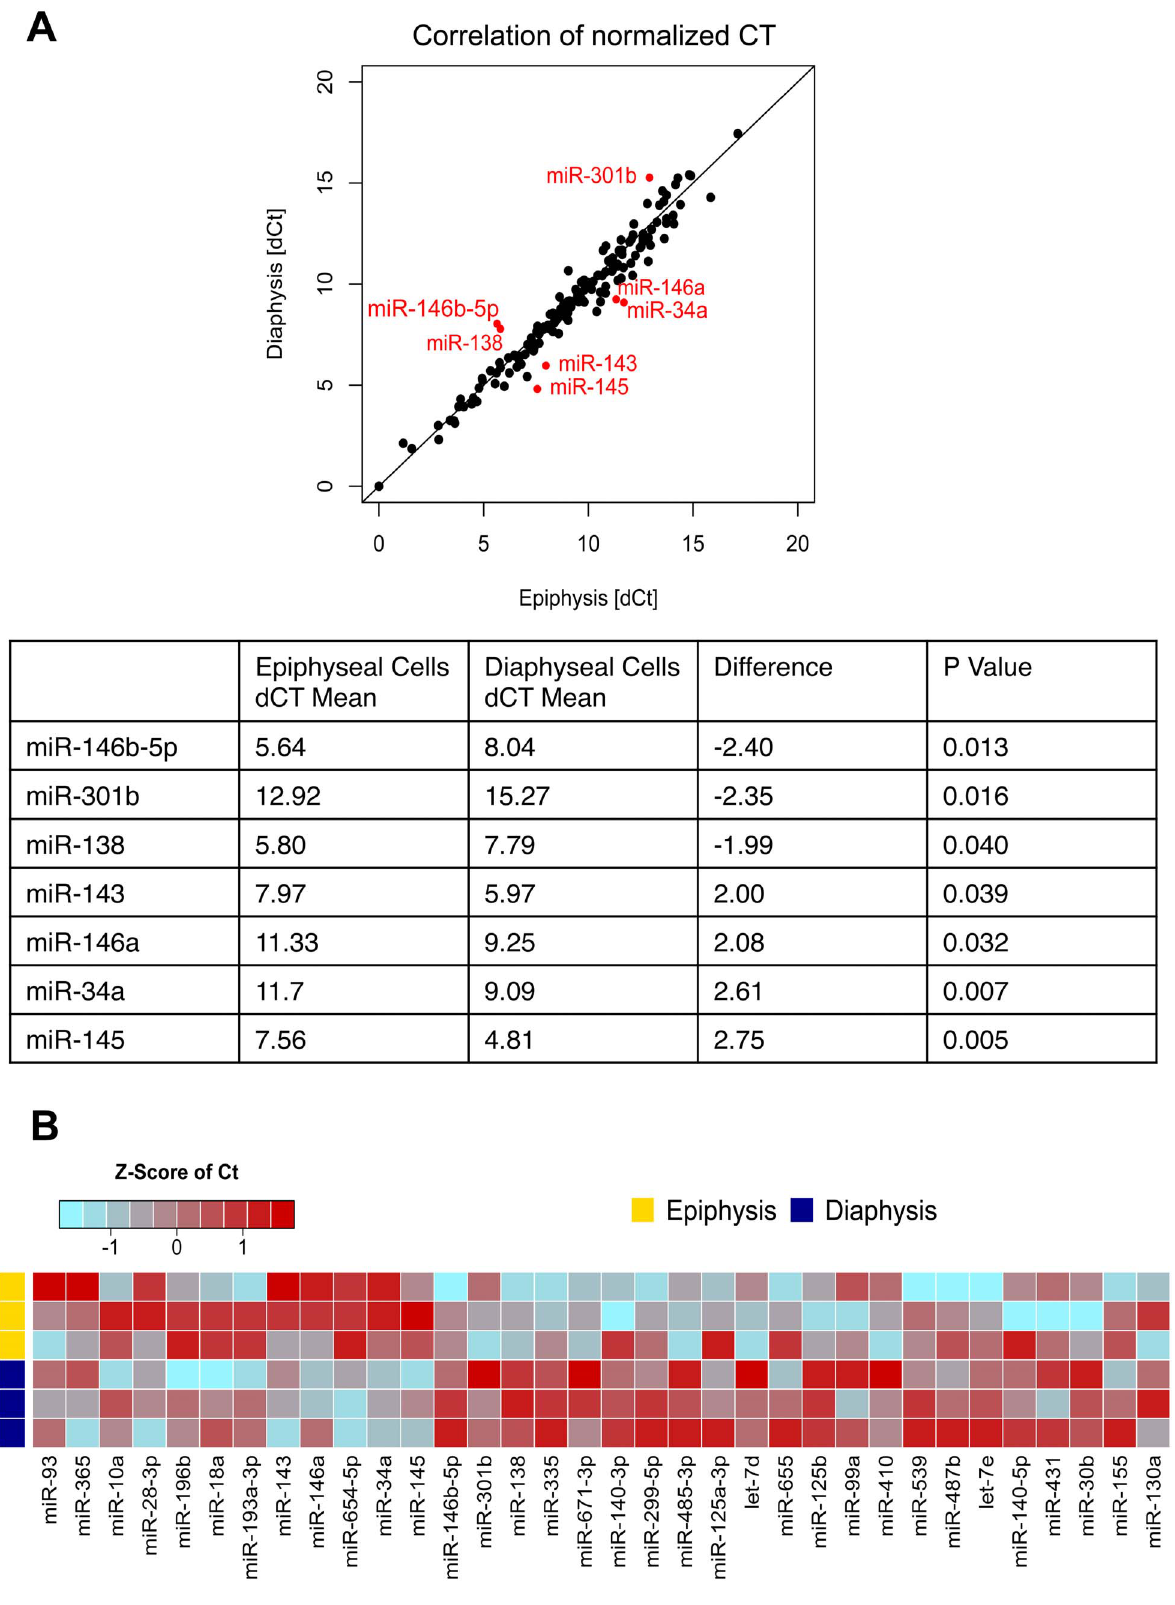
Figure 4. MicroRNA expression profile of epiphyseal and diaphyseal cells. CT values of each miR was normalized to MammU6 (dCT) and plotted as an XY scattered chart displaying the correlation of miR expression by epiphyseal and diaphyseal cells. An unpaired t-test revealed 7 miRs with significant differences in expression: miR-146a-5p, miR-301b and miR-138 displayed higher expression in epiphyseal cells while miR-143, miR-